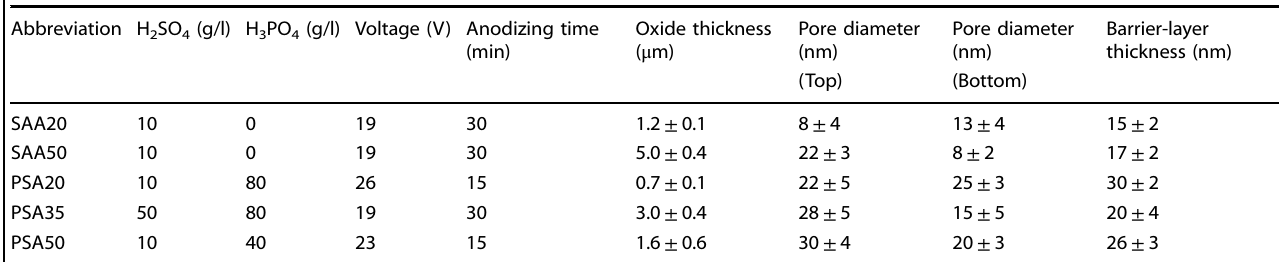
Table 1. Anodizing conditions and measured oxide features (TEM) for the selected samples shown in Figs. 1 and